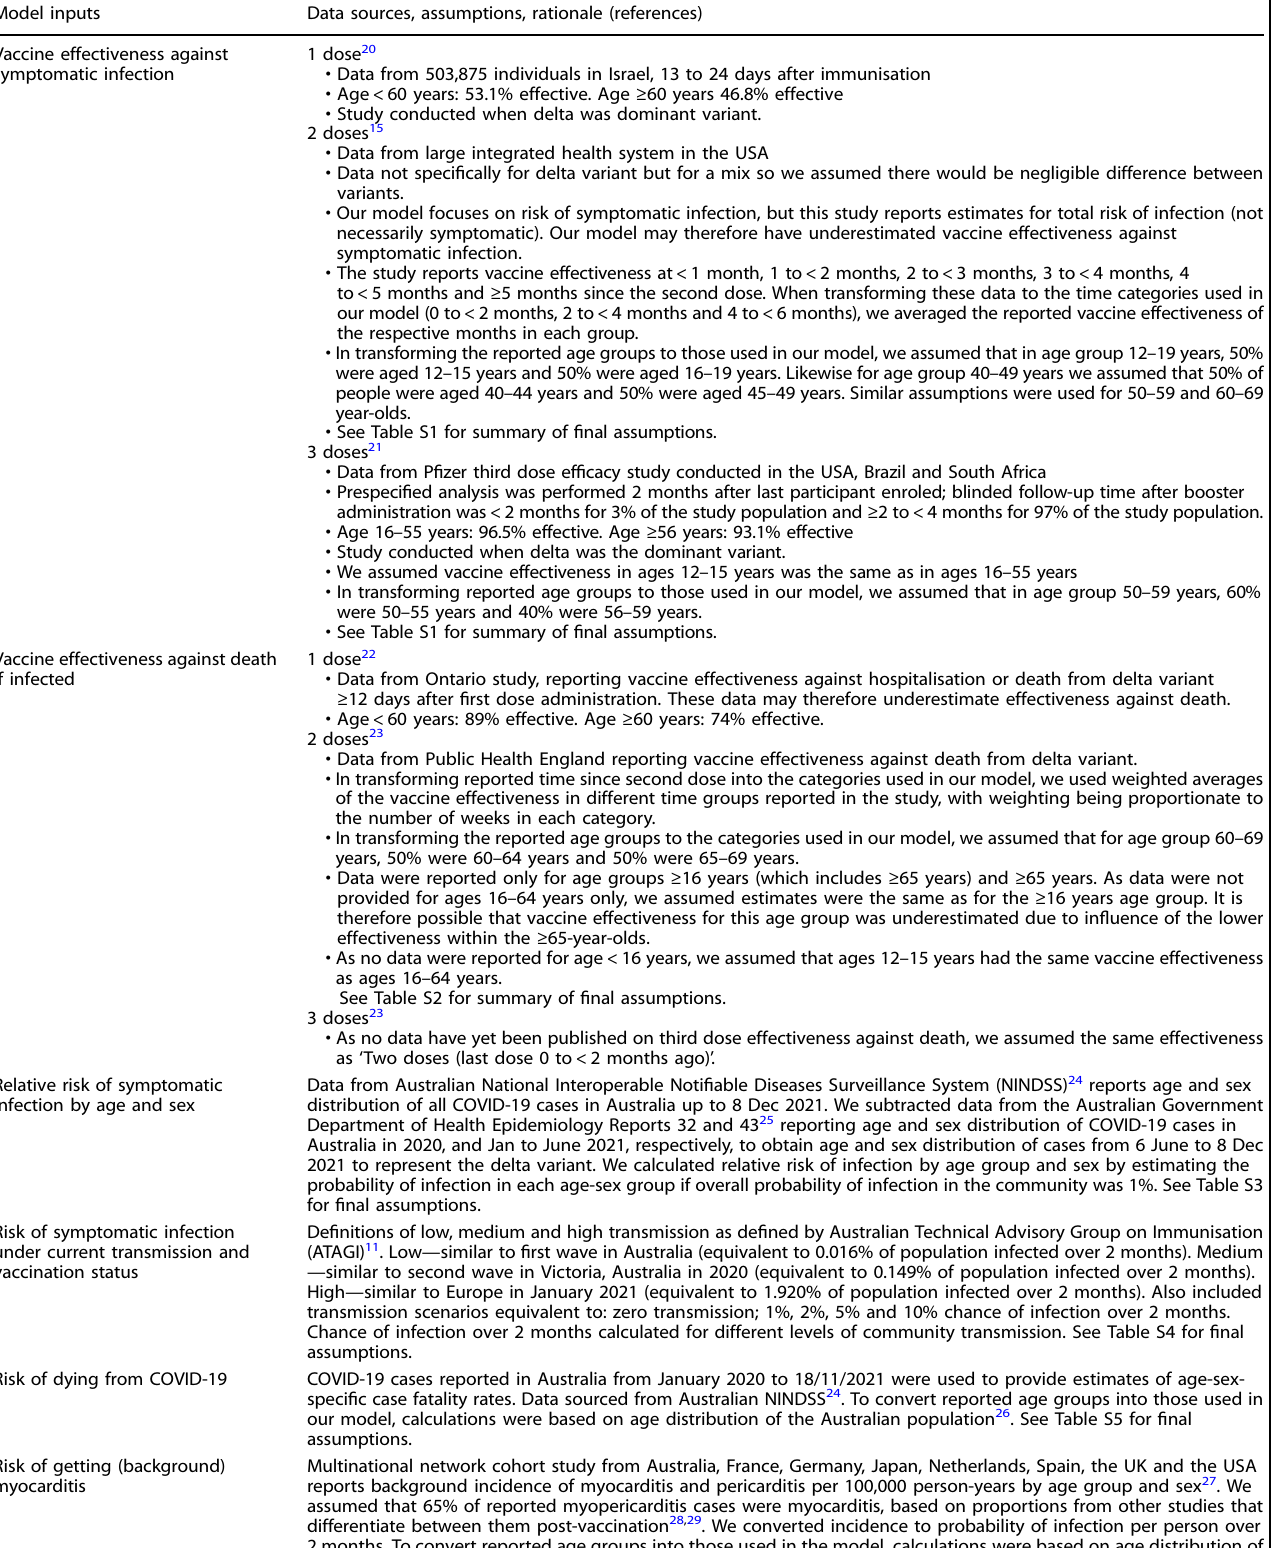
Table 1. Summary of data sources, assumptions and prior distributions for a Bayesian network to assess risks versus bene fi ts of the P fi zer COVID-19